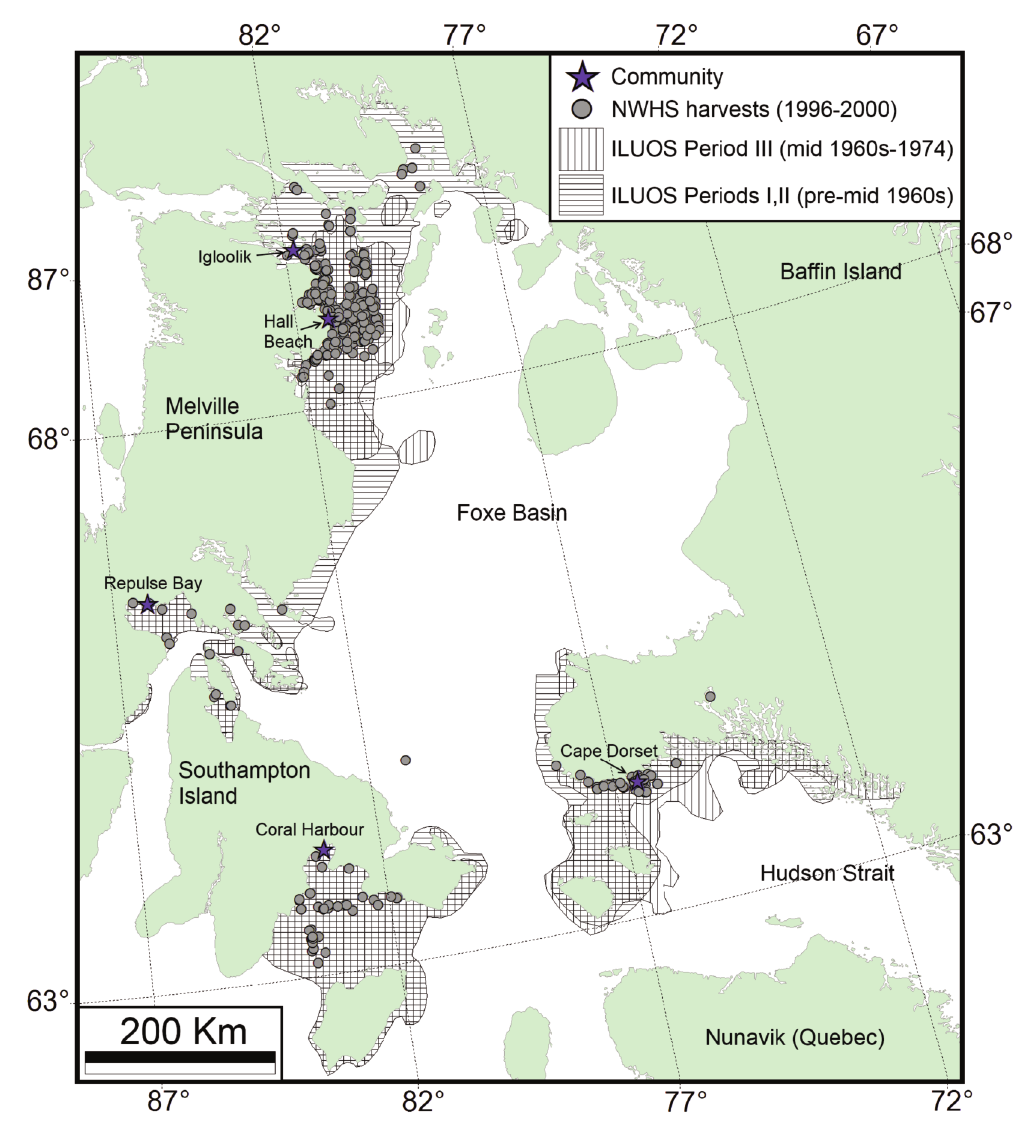
Fig. 18. Areas where Inuit from the communities of Igloolik, Hall Beach, Repulse Bay, Coral Harbour and Cape Dorset hunted walruses prior to the mid-1960s, from then until 1974, and between 1996 and 2000. Data for harvest areas used prior to 1974 are from the Inuit Land Use and Occupancy Study (‘ILUOS’)—period III began in 1965 for Igloolik and Hall Beach (Brody 1976), 1963 for Repulse Bay (Brice-Bennett 1976), 1962 for Coral Harbour (Welland 1976), and 1965 for Cape Dorset (Kemp 1976) (see also supporting maps in Freeman 1976). The 1996 to 2000 data are from the Nunavut Wildlife Harvest Study (NWHS) (Priest and Usher